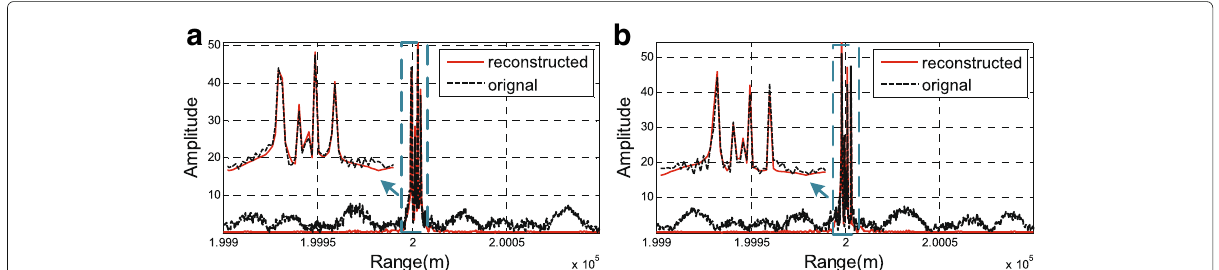
Fig. 6 Separated echoes comparison before and after clean reconstruction. a The echo of up-chirp waveform. b The echo of down-chirp waveform